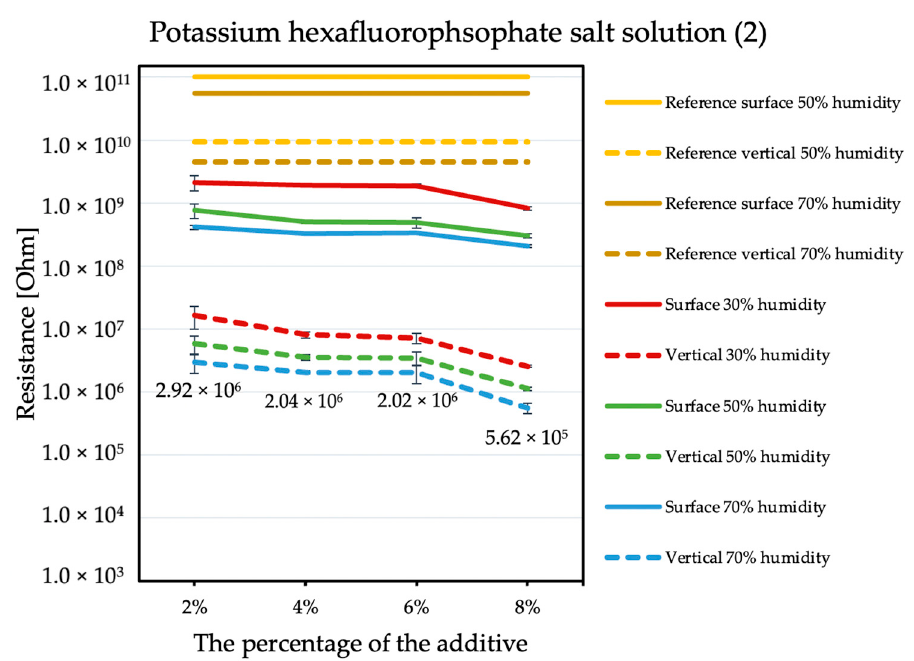
Figure 2 . Resistances of coatings with potassium hexafluorophosphate solution additive.